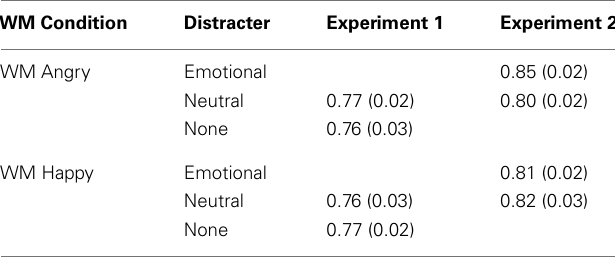
Table 2 | Group mean proportion correct scores for each